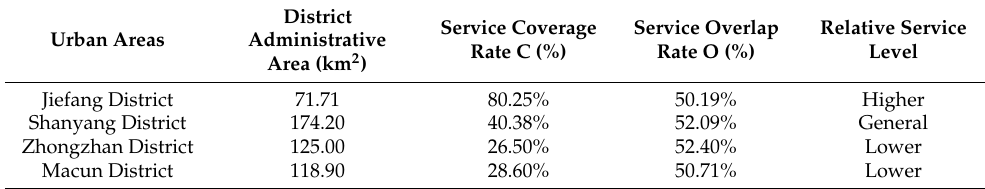
Table 6. The service coverage and service overlap indices of parks and squares in the main urban area in